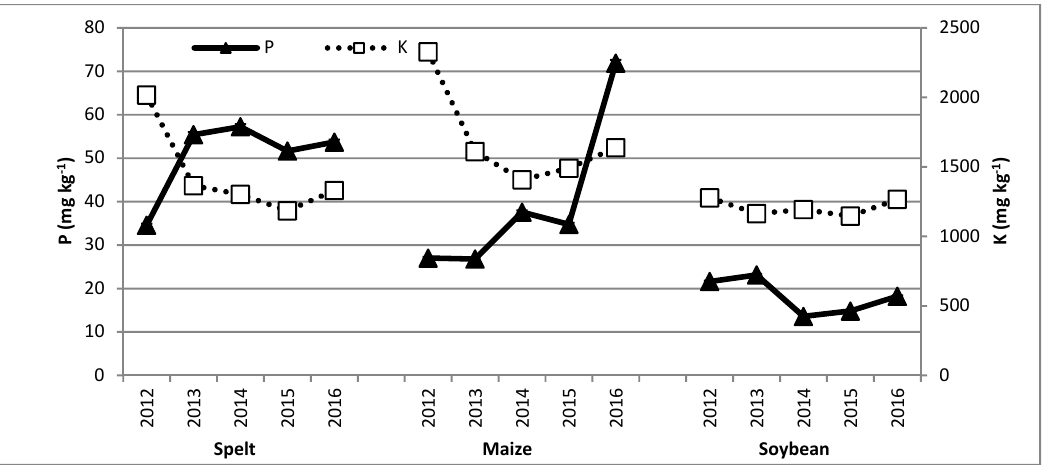
Figure 2. The status of available P and K in soil across seasons, under organic production (bars represent SD values).